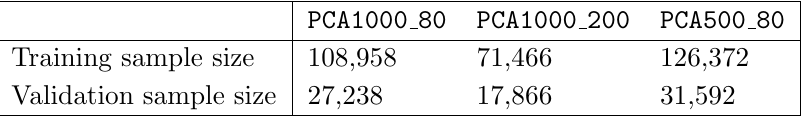
Table 3 . Training sample sizes for PCA